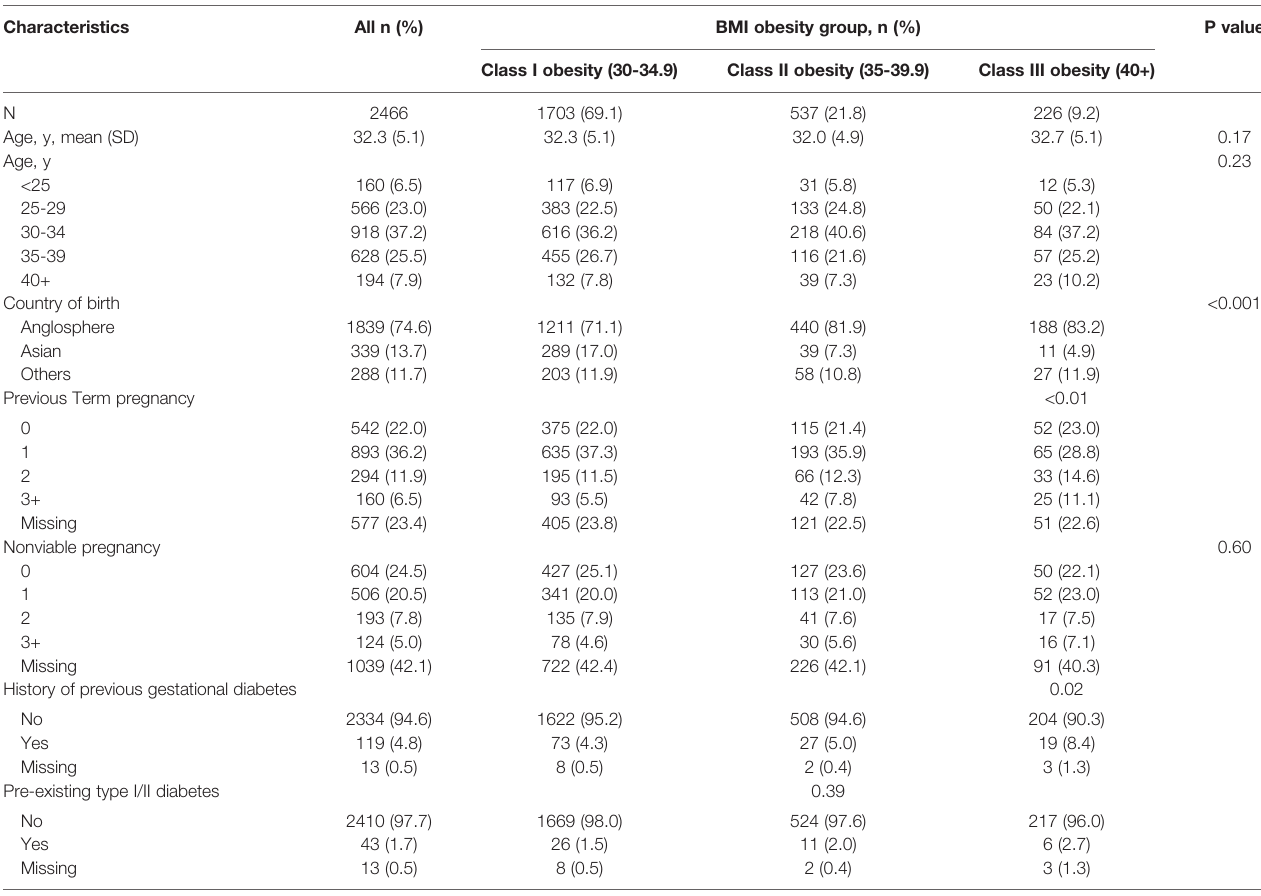
TABLE 1 | Women ’ s socio-demographic and clinical characteristics by obesity class.